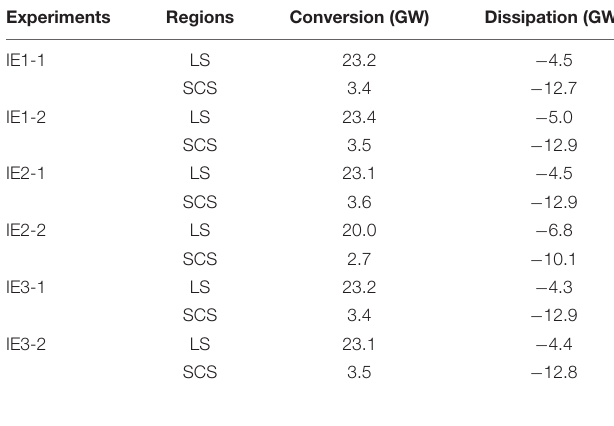
TABLE 2 | Conversion and dissipation rate of the baroclinic tidal energy